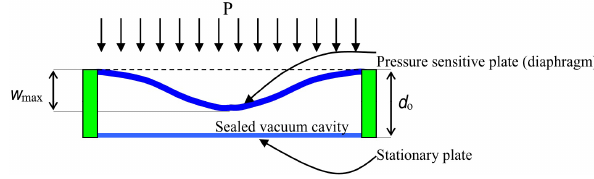
Figure 9. Schematic diagram of a general capacitive pressure sen- sor.